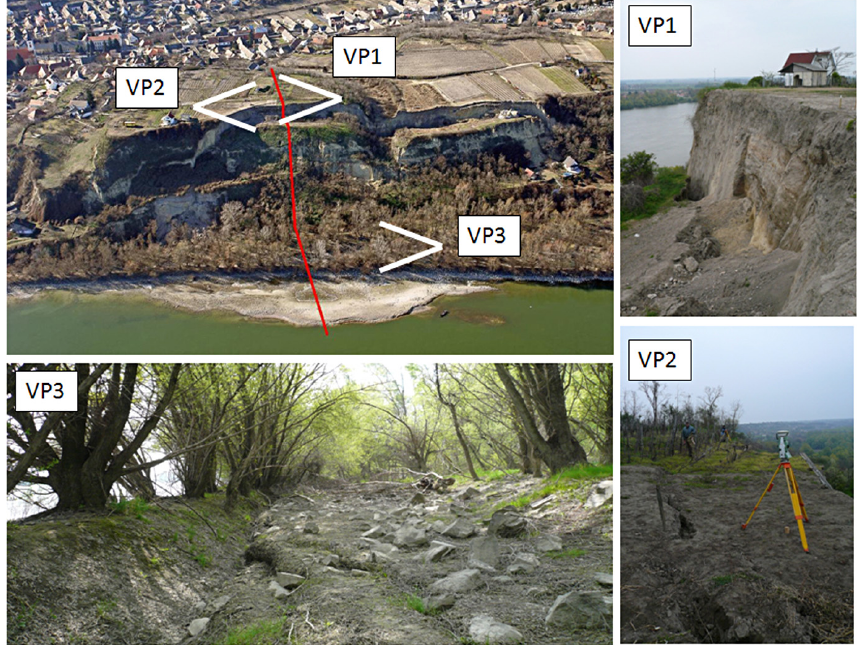
Fig. 3. Morphological features documented by terrestrial photos; viewpoint 1: the main scarp; viewpoint 2: tension cracks behind the main scarp; viewpoint 3: deformation zone at the river bank, indicating a second sliding plane; Red line in overview marks the profile used for 2-D